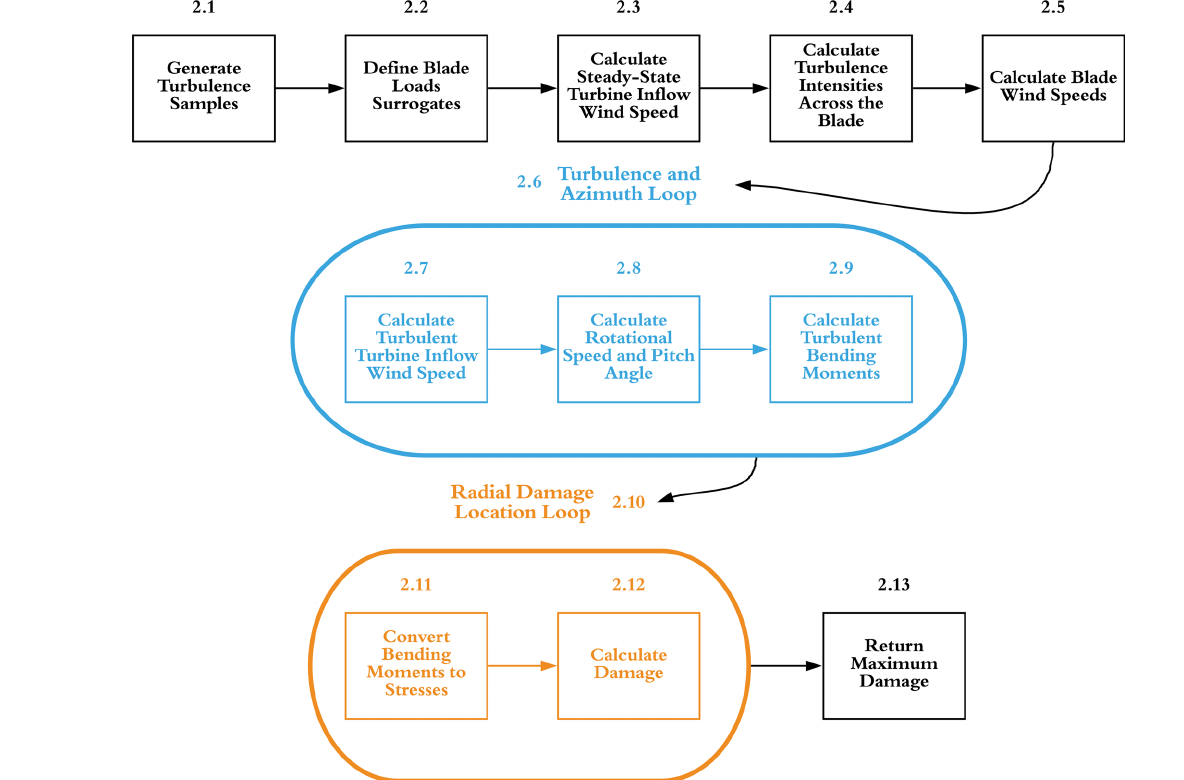
Figure 1. A flow chart of the damage calculation model used in this study.